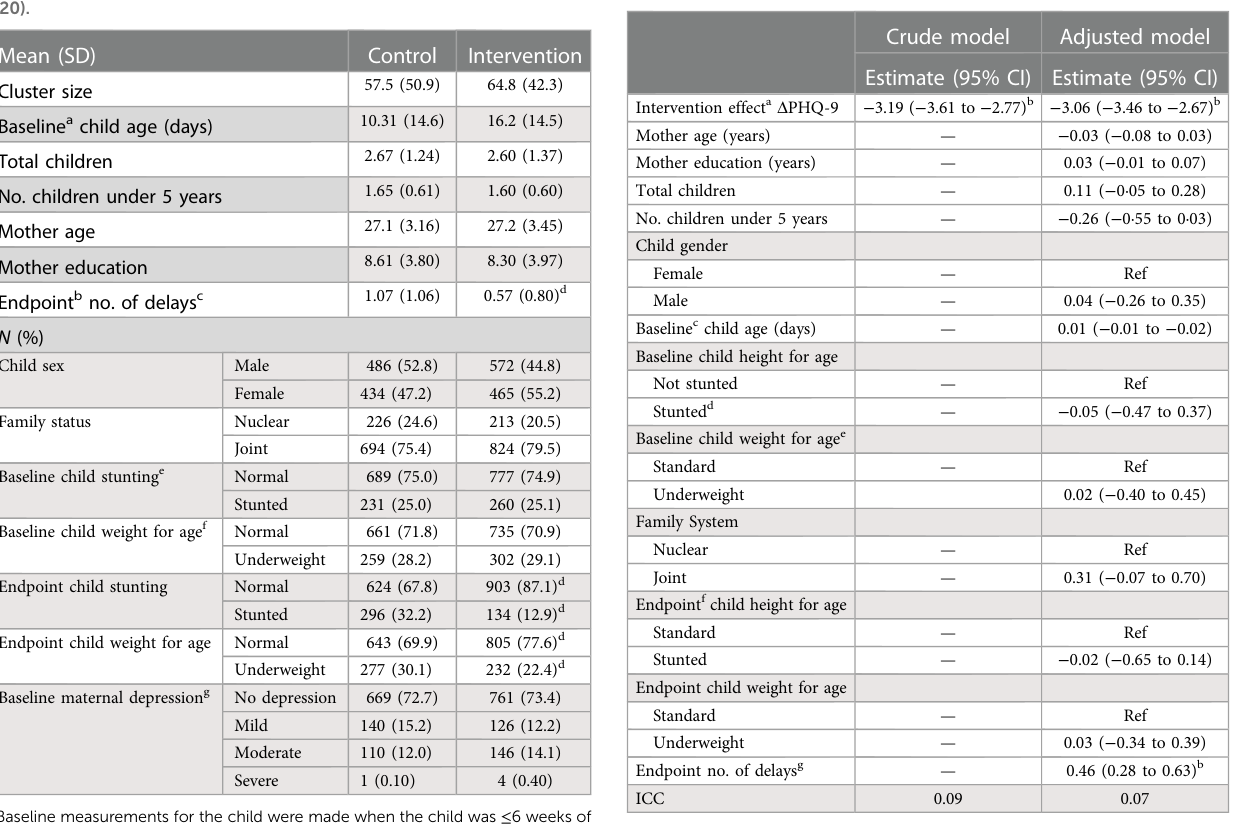
TABLE 2 Change in PHQ-9 scores for mothers after 12 months ( N =1,957, intervention=1,037,